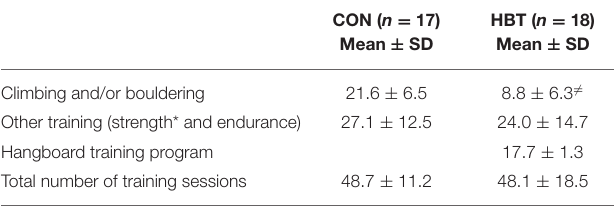
TABLE 2 | Number of self-reported training sessions within the 10-week